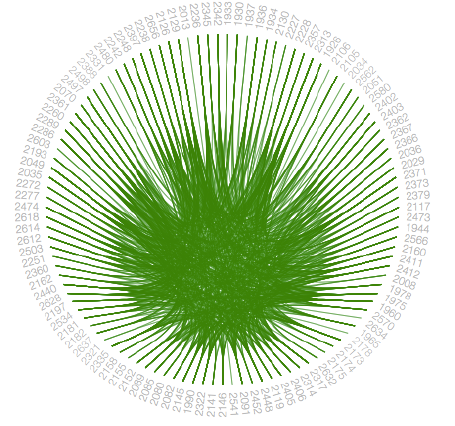
Figure 15. Represents hierarchical edge bundling visualization with low bundling strength.